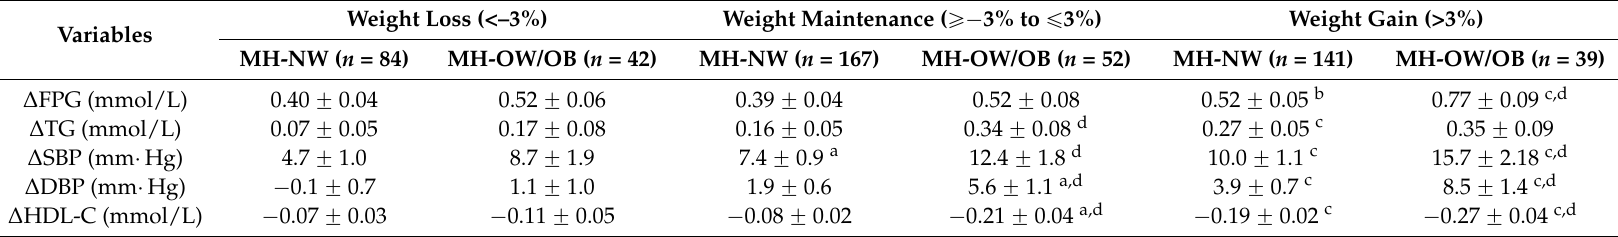
Table 2. Comparison of 5-year change of the metabolic parameters between the subjects of MH-NW and MH-OW/OB and within weight change category.